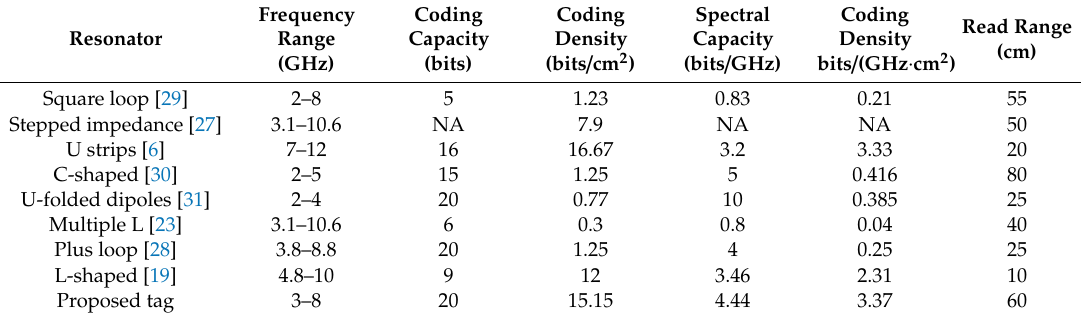
Table 6. Comparison with di ff erent chipless RFID